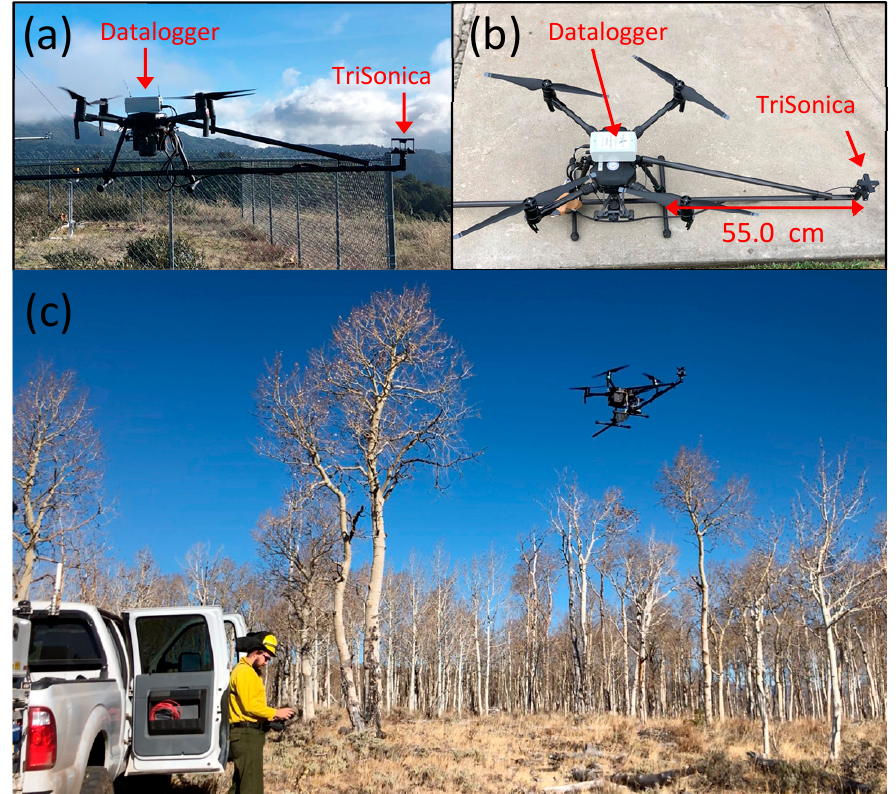
Figure 1. Photos of UAS system to showing system setup, design and operation. ( a ) Horizontal view of system while hovering. ( b ) The TriSonica was mounted on a carbon fiber pole extending 55 cm off the body of the UAS with the data logger fixed to the top of the platform. ( c ) The profiling flight in the Fishlake National Forest, Utah, 7 November 2019.